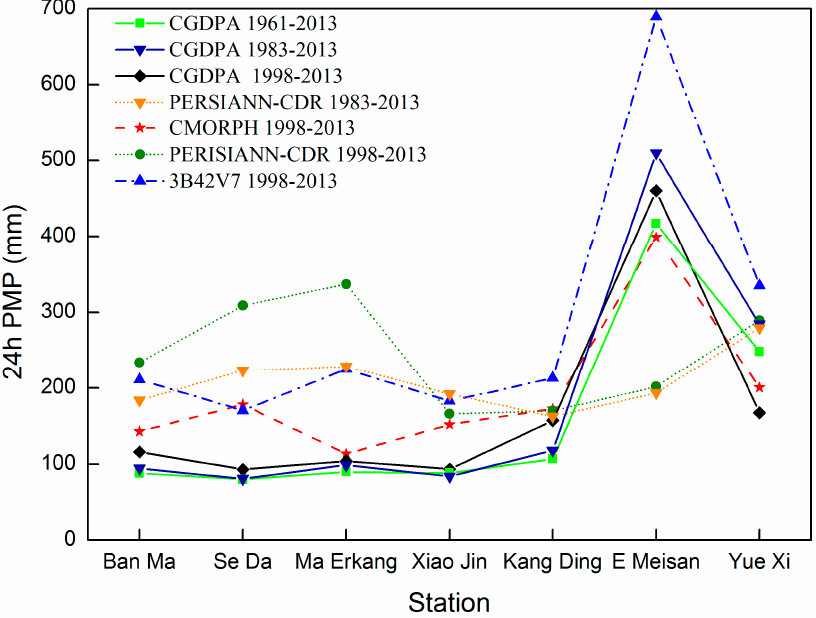
Figure 8. Comparison of 24-h PMP values derived from satellite precipitation and gauge-based precipitation. Table 4. Summary of spatial Correlation Coefficient (CC) values for the three satellite precipitation products in the Dadu River basin during 1998–2013. The CCs were calculated based on the 160 grids across the basin.